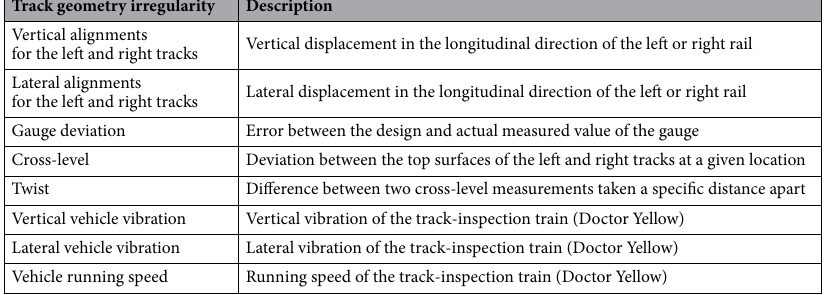
Table 1. Track geometry